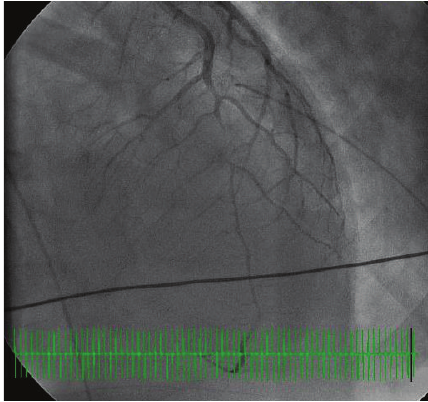
Figure 2: Left heart catheterization representing 99% occlusion of mid-distal LAD.